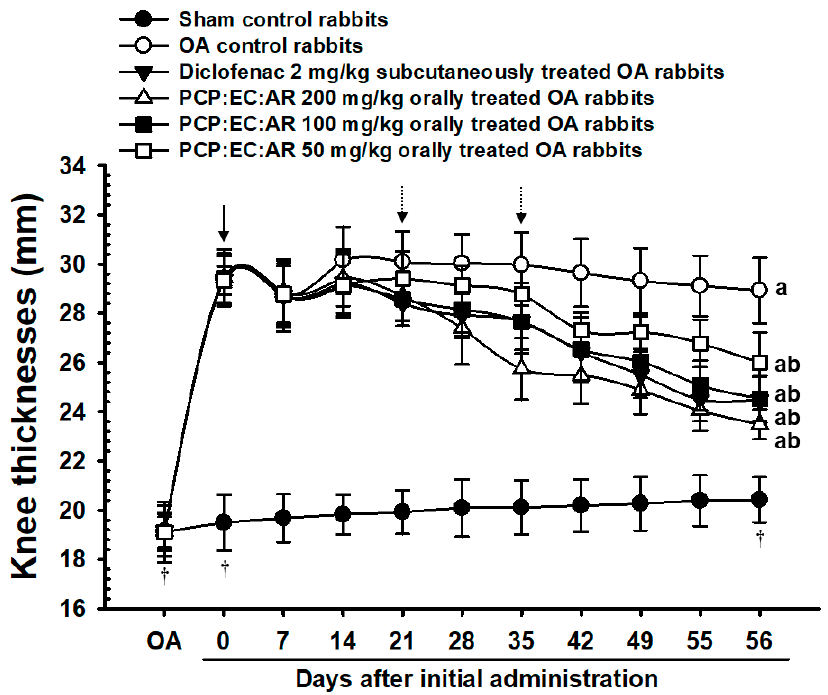
Figure 1. Knee thickness changes in sham-operated or OA rabbits. Significant ( p < 0.01) increases of knee thicknesses were demonstrated in OA control rabbits from 35 days after OA (one day before initial administration) as compared with sham control rabbits, throughout the whole experiment periods in the present study (arrow). Significant ( p < 0.01 or p < 0.05) decreases of knee thicknesses were demonstrated in diclofenac, PCP: EC:AR mixed formula 100 and 200 mg / kg treated rabbits from 21 days after initial administration as compared with OA control rabbits, and from 35 days after initial administration in PCP:EC:AR mixed-formula 50 mg / kg treated rabbits as compared with OA control rabbits, respectively (dot arrows). Values are expressed as mean ± S.D. of eight rabbits, mm. OA =